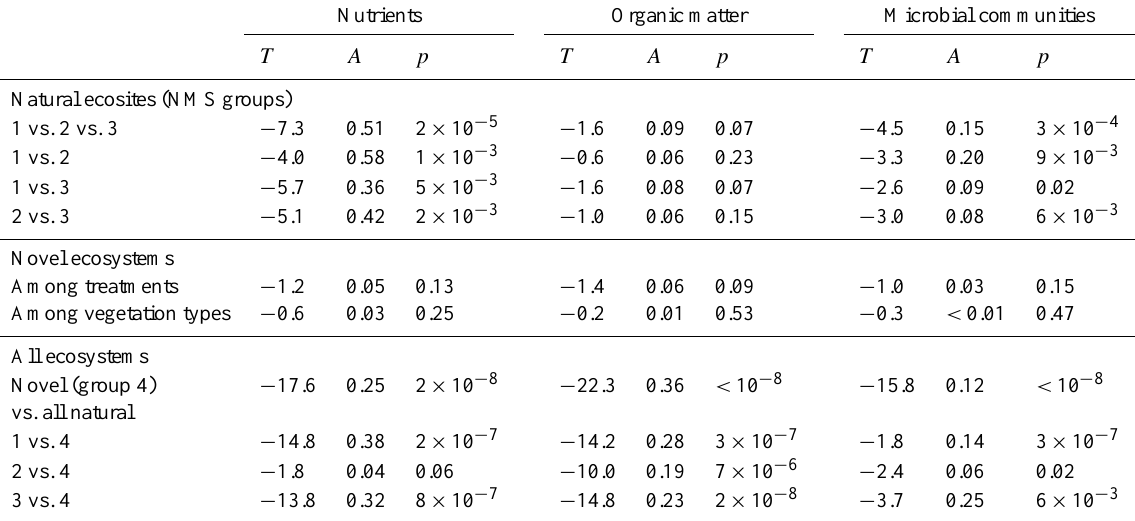
Table 2. Multi-response permutation procedure results for soil nutrient supply (PRS), organic matter composition (NMR), and microbial community structure (PLFA).